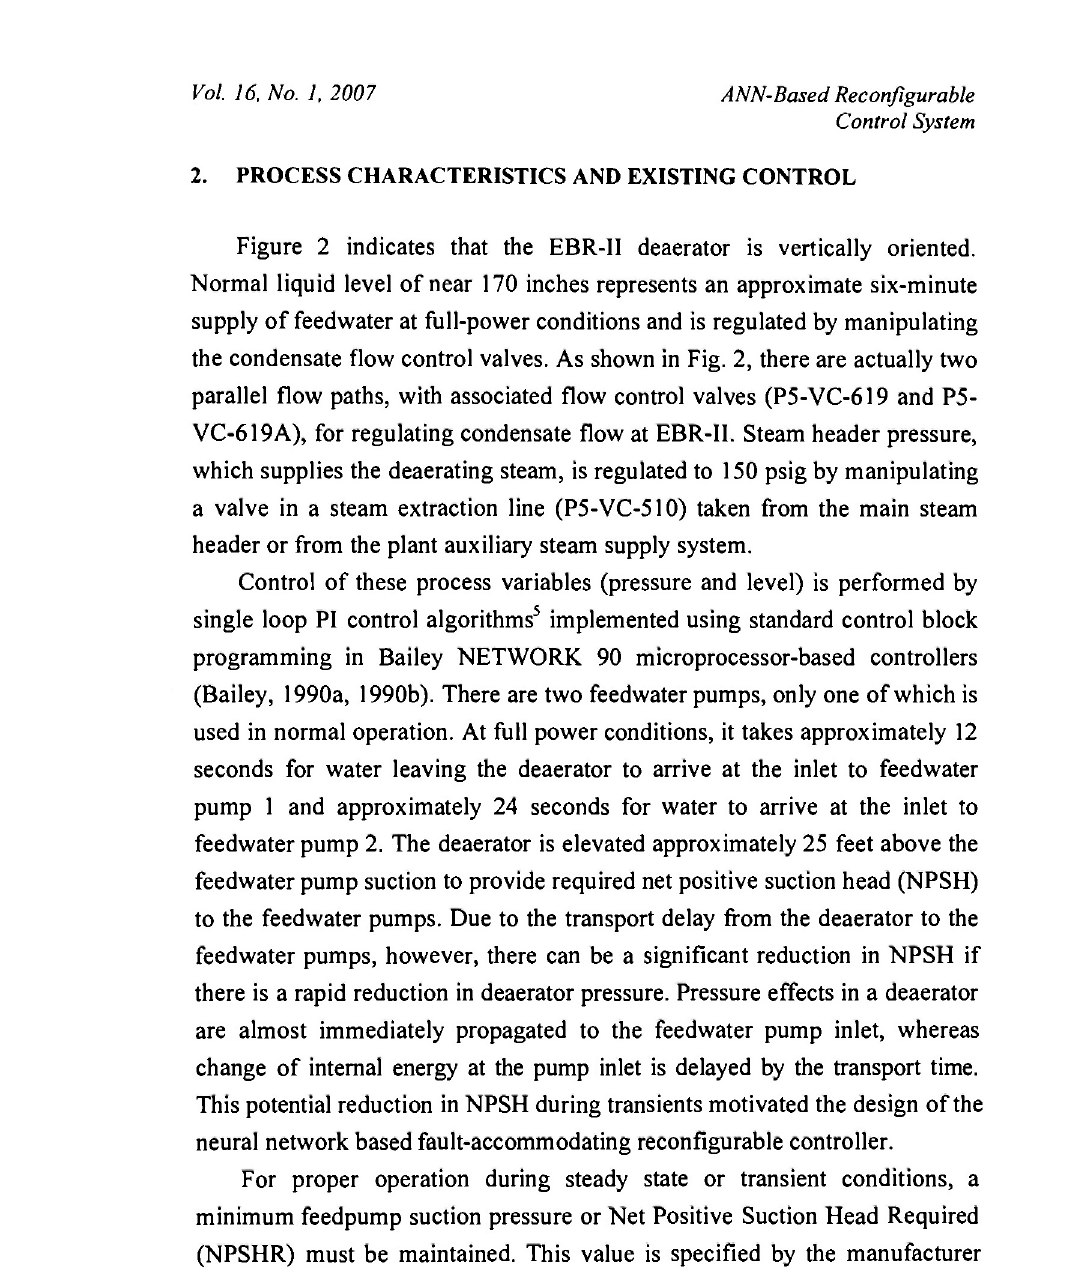
Figure 2 indicates that the EBR-II deaerator is vertically